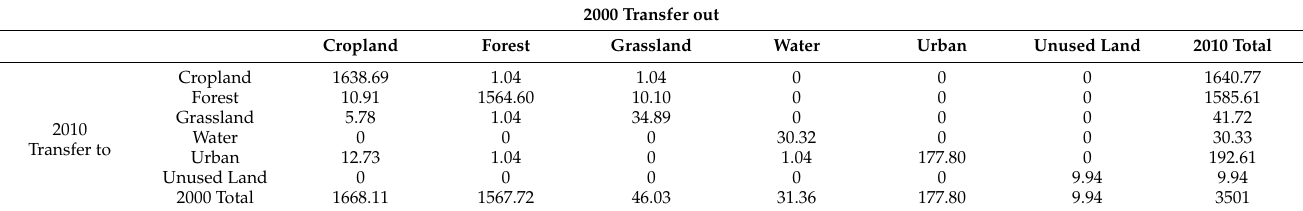
Table 7. Land Use Transfer Matrix 2000~2010 (km 2 ).